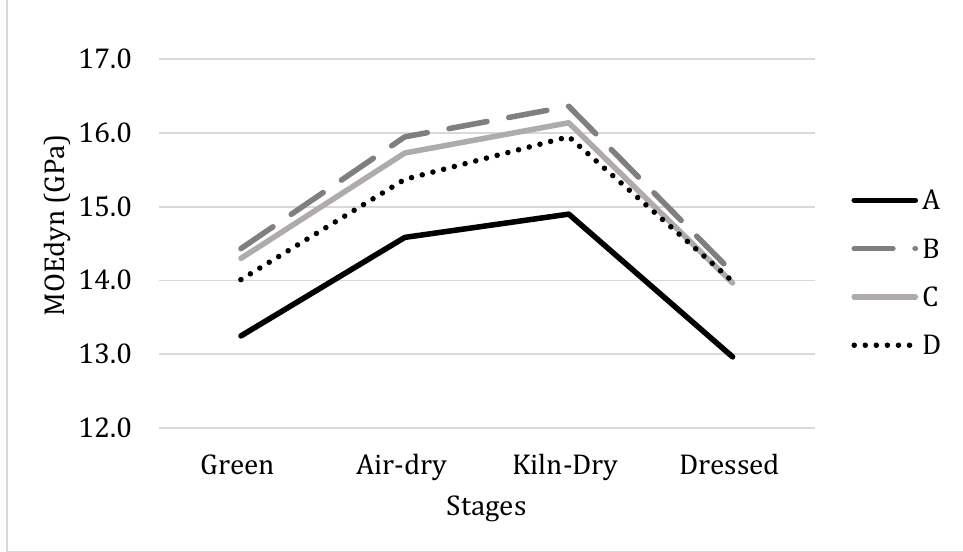
Figure 1. Modulus of elasticity of boards measured at different treatment stages. On the x -axis dynamic modulus of elasticity (MOE dyn ) measured through acoustic wave velocity (AWV) is reported at each stage (green, air-dry, kiln-dry, and dressed). Letters (A, B, C, D) indicate the log position, with increasing position in the stem from A to D. Standard errors for green and dressed stages are reported in Table 3. Standard errors for air-dry stage are: Log A (3.12), log B (3.18), log C (2.77), log D (1.22), and for kiln-dry stage are: Log A (3.28), log B (3.30), log C (2.36), log D (1.41). Air-dry and kiln-dry MOE dyn values were significantly higher than green MOE dyn for all log positions (Figure 1). Dressed MOE dyn was not significantly different between green MOE dyn for boards coming from the first, second, and top logs (log A t(106) = 2.53, p = 0.07, log B t(83) = 2.31, p = 0.14, log D t(14) = 0.09, p = 1), but significantly different for boards coming from third logs (log C t(65) = 3.42, p < 0.05). Dressed MOE dyn was also significantly lower than kiln-dry MOE dyn (log A t(106) = 17.7, p < 0.001, log B t(83) = 13.9, p < 0.001, log C t(65) = 20.5, p < 0.001, log D t(14) = 6.72, p < 0.001). There were no significant differences between modulus of elasticity measured at the green stage or dressed stage through AWV and actual modulus of elasticity measured at the dressed stage via mechanical testing (F = 1.94, p = 0.15); however, significant differ- ences among log positions were present (F = 17.3, p < 0.001). There was no interaction between log position and measurement type (F = 0.17, p = 0.99). Table 3 reports the values of modulus of elasticity at the green and dressed stages measured via AWV (MOE dyn ) and actual modulus of elasticity measured mechanically (MOE stat ). Table 3. Repeated measures ANOVA results table of modulus of elasticity measured at different green and dressed stages (as MOE dyn and MOE stat ) in boards coming from logs of different posi- tions in the stems (bottom A, middle B and C and top logs D). Different letters across rows denote differences in modulus of elasticity at the various processing stages for boards coming from the same log. Log Position